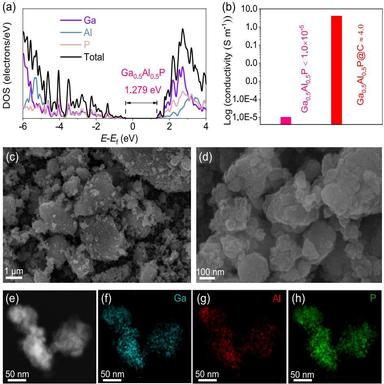
(a) Density of state (DOS). (b) Electronic conductivity measurements of the Ga0.5Al0.5P compound and its graphite composite. (c and d) Scanning electron microscope (SEM) images. (e-h) Element mappings of graphite-modified Ga0.5Al0.5P compound.